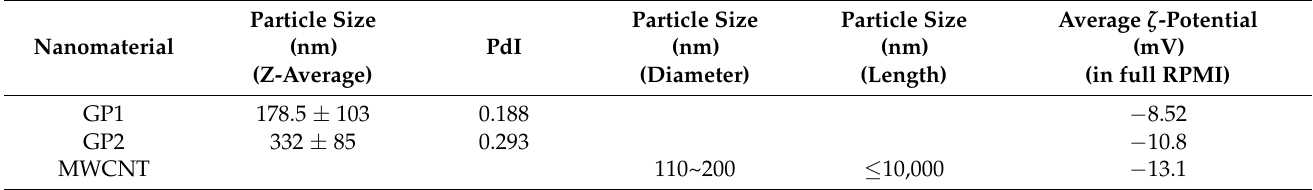
Table 1. Physical properties of GPs and MWCNTs